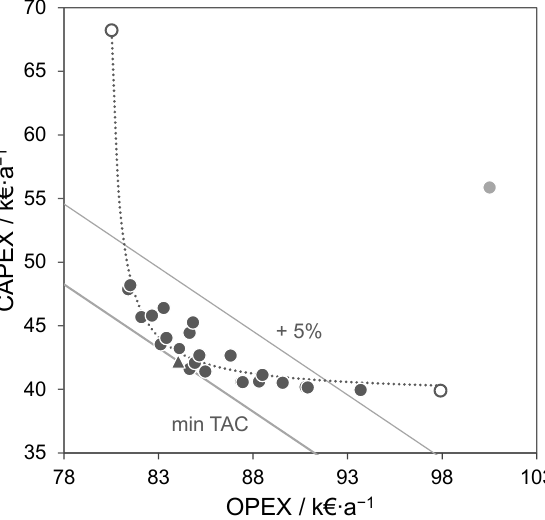
Figure 12. Set of solutions close to Pareto-optimality for the heteroazeotropic distillation of 1,4-dioxane and water using benzene as solvent. The white circles indicate the individual optimization of the OPEX and CAPEX, respectively, and the thick and thin lines are lines of constant TAC for the lowest costs and an additional 5%. The light-gray circle denotes a locally optimized but finally sub-optimal solution, which is not in close vicinity to the approximated Pareto front and omitted for the fit of Equation (2) shown as a dotted